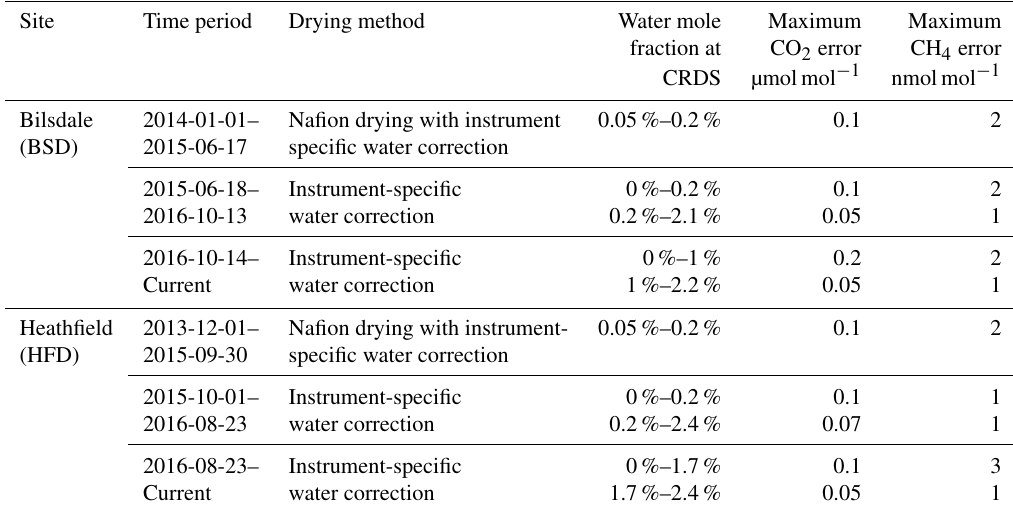
Table 5. Estimates of the maximum error associated with the measurement of ambient CO 2 and CH 4 mole fraction samples using the given drying and/or water correction method for the BSD and HFD